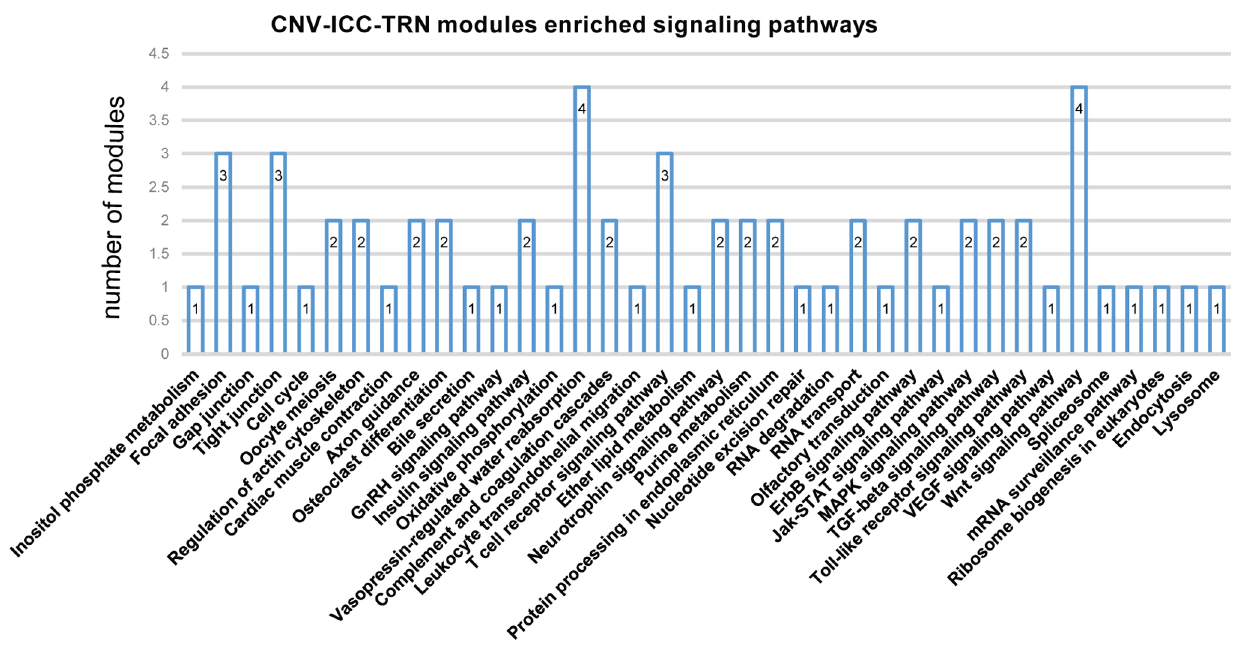
Figure 3. Biological functions tackled in modules of CNV-ICC-TRN. X-axis represents signaling pathways and IDs, y-axis represents the number of modules enriching to each pathway. Complete information is shown in Table S3.